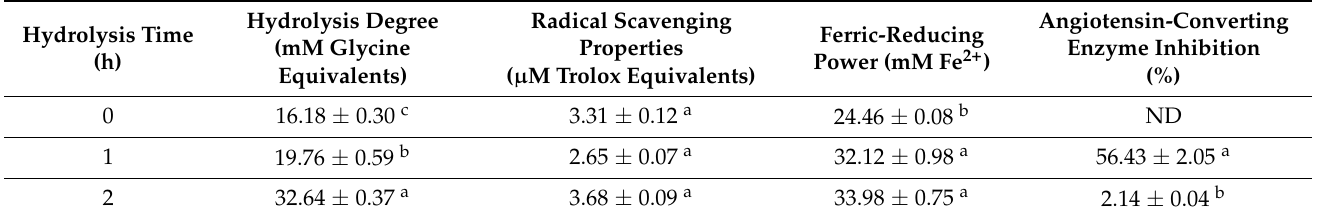
Table 1. Hydrolysis degree and bioactive properties from trout muscle hydrolysates